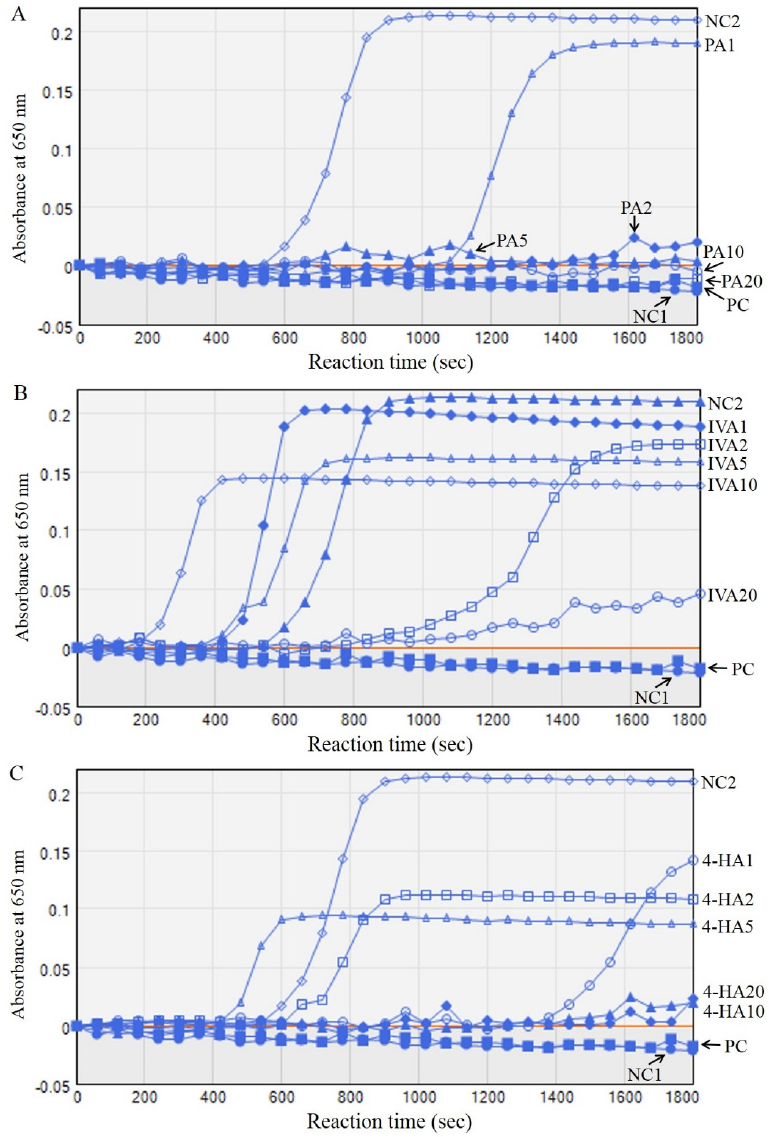
Figure 5. Effect of PA ( A ), IVA ( B ), and 4-HA ( C ) on recalcification time and plasma density. Human platelet-poor plasma was mixed with PA, IVA, and 4-HA dissolved in DMSO in 96-well plates and incubated for 10 min at 37 ◦ C. Thereafter, 100 mM pre-warmed CaCl 2 was added to the mixture and absorbance was taken every 60 s at 650 nm for 30 min in a microplate reader. The plasma density was presented as the optical density at 650 nm after 30 min. The half time (s) was presented as reaching a half-maximum absorbance value. NC1, plasma only; NC2, plasma treated with CaCl 2 ; PC, positive control group (1 U heparin); PA1–20, 1–20 µ g of PA treated; IVA1–20, 1–20 µ g of IVA treated; 4-HA1–20, 1–20 µ g of 4-HA